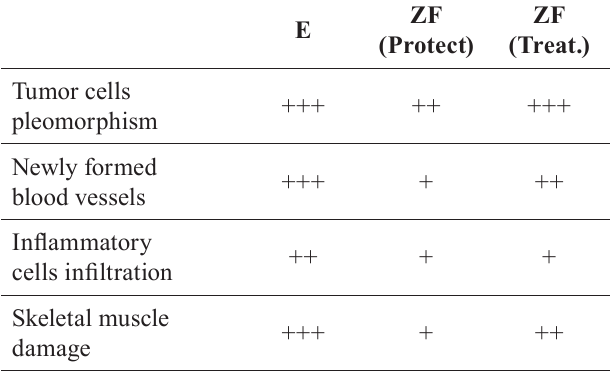
Table II - Effect of oral administration of zofenopril (15 mg/kg/day) on severity of histopathological alterations in tumors isolated from EST-bearing mice